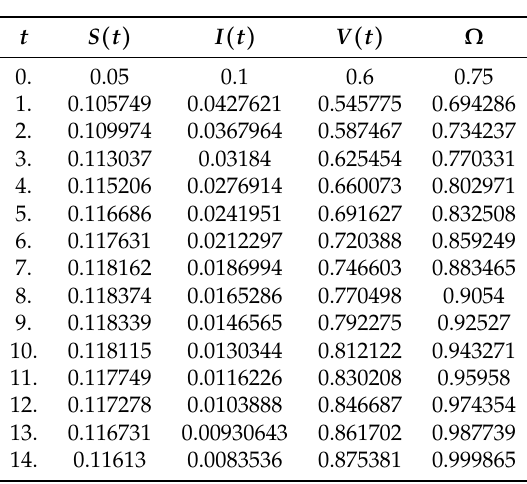
Figure 1. Population fraction verses time for Case 1: α 1 = α 2 = α 3 = 1. Table 3. α 1 = α 2 = α 3 =